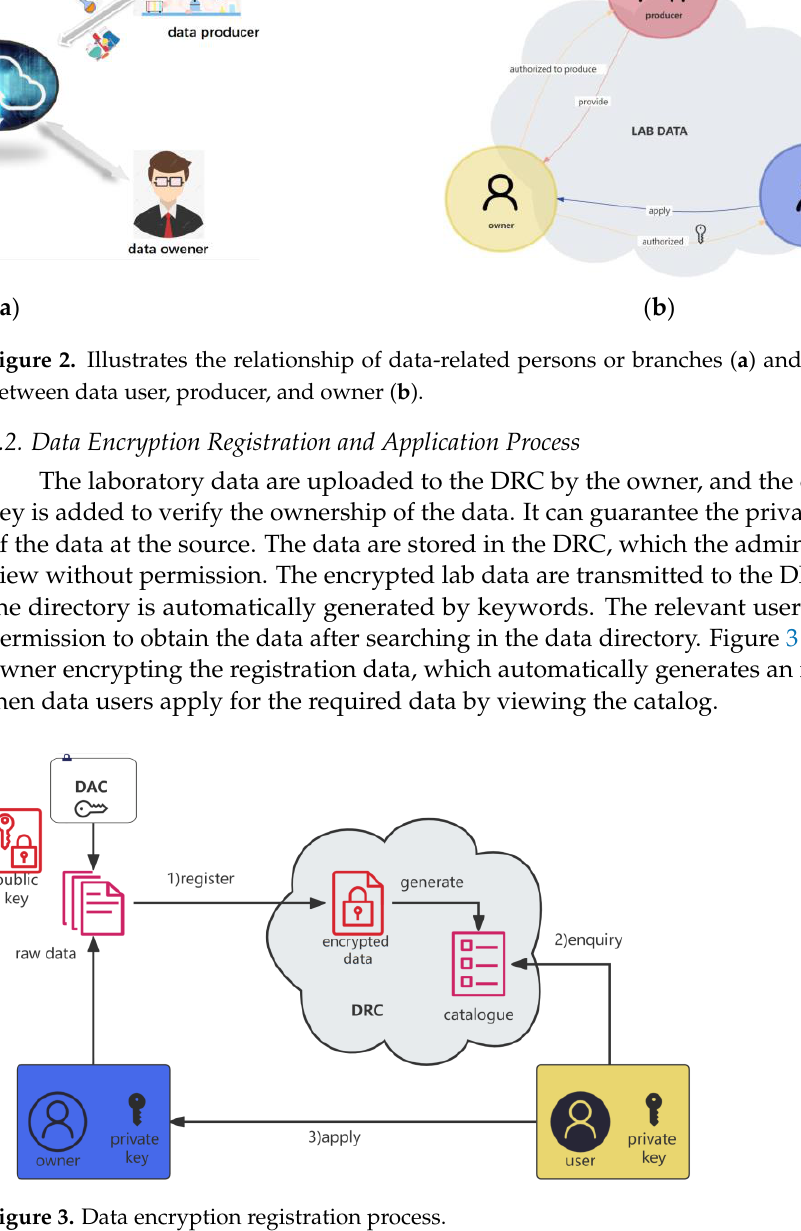
Table 3. The definition of symbols used. Symbols